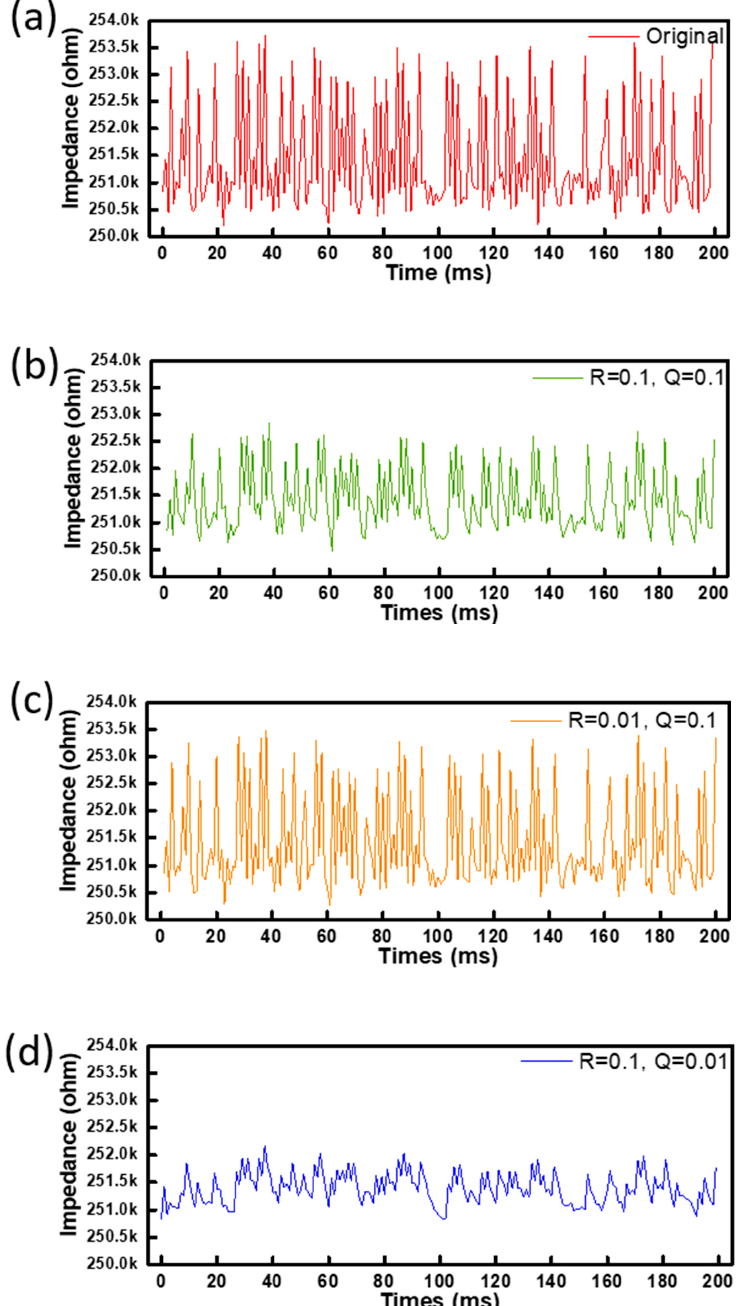
Figure 4. Time-dependent response of the single flexible pressure sensor with ( a ) designed noises of input by the modification of R and Q for ( b ) 0.1 / 0.1, ( c ) 0.01 / 0.1 and ( d ) 0.1 / 0.01 in the Kalman filter.